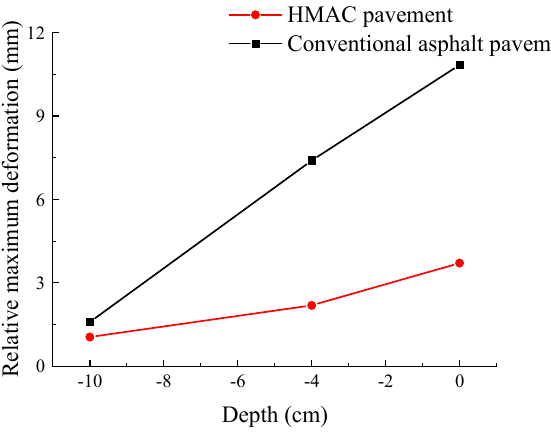
Figure 14. Comparison of the relative maximum deformation of two types of pavement at different depths.